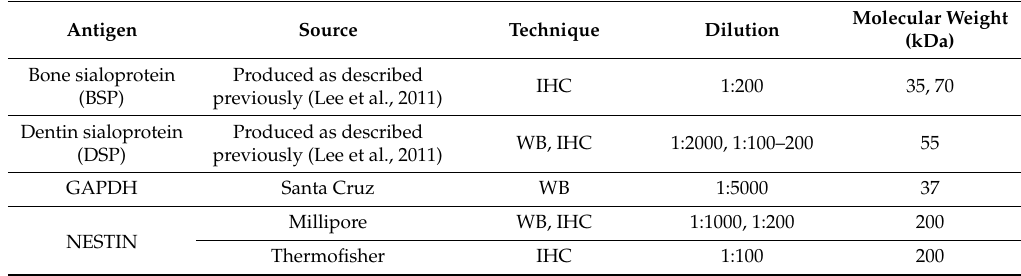
Table 2. List of antibodies for